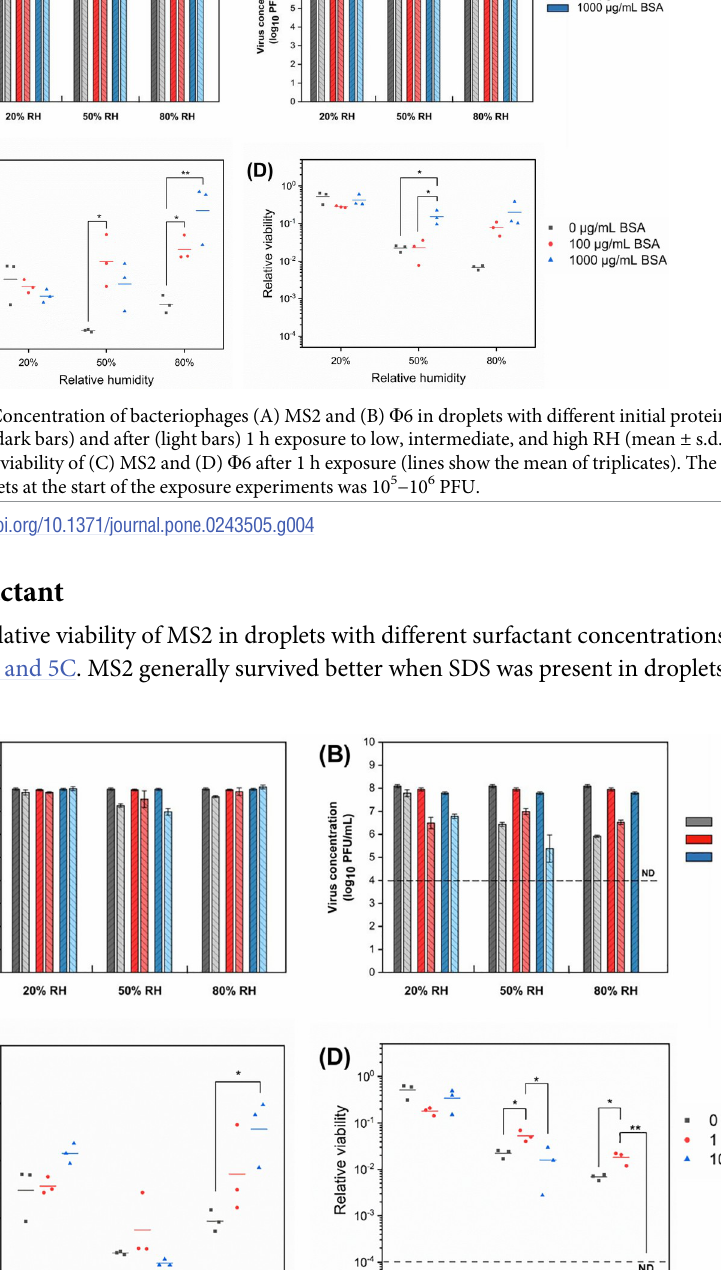
Fig 5. Concentration of bacteriophages (A) MS2 and (B) F 6 in droplets with different initial surfactant concentration before (dark bars) and after (light bars) 1 h exposure to low, intermediate, and high RH (mean ± s.d. of triplicates). Relative viability of (C) MS2 and (D) F 6 after 1 h exposure (lines show the mean of triplicates). The number of virions in droplets at the start of the exposure experiments was 10 5 − 10 6 PFU. The dark gray dashed line indicates the detection limit (10 4 PFU/mL) of plaque assay. ND indicates no viable virus was detected.